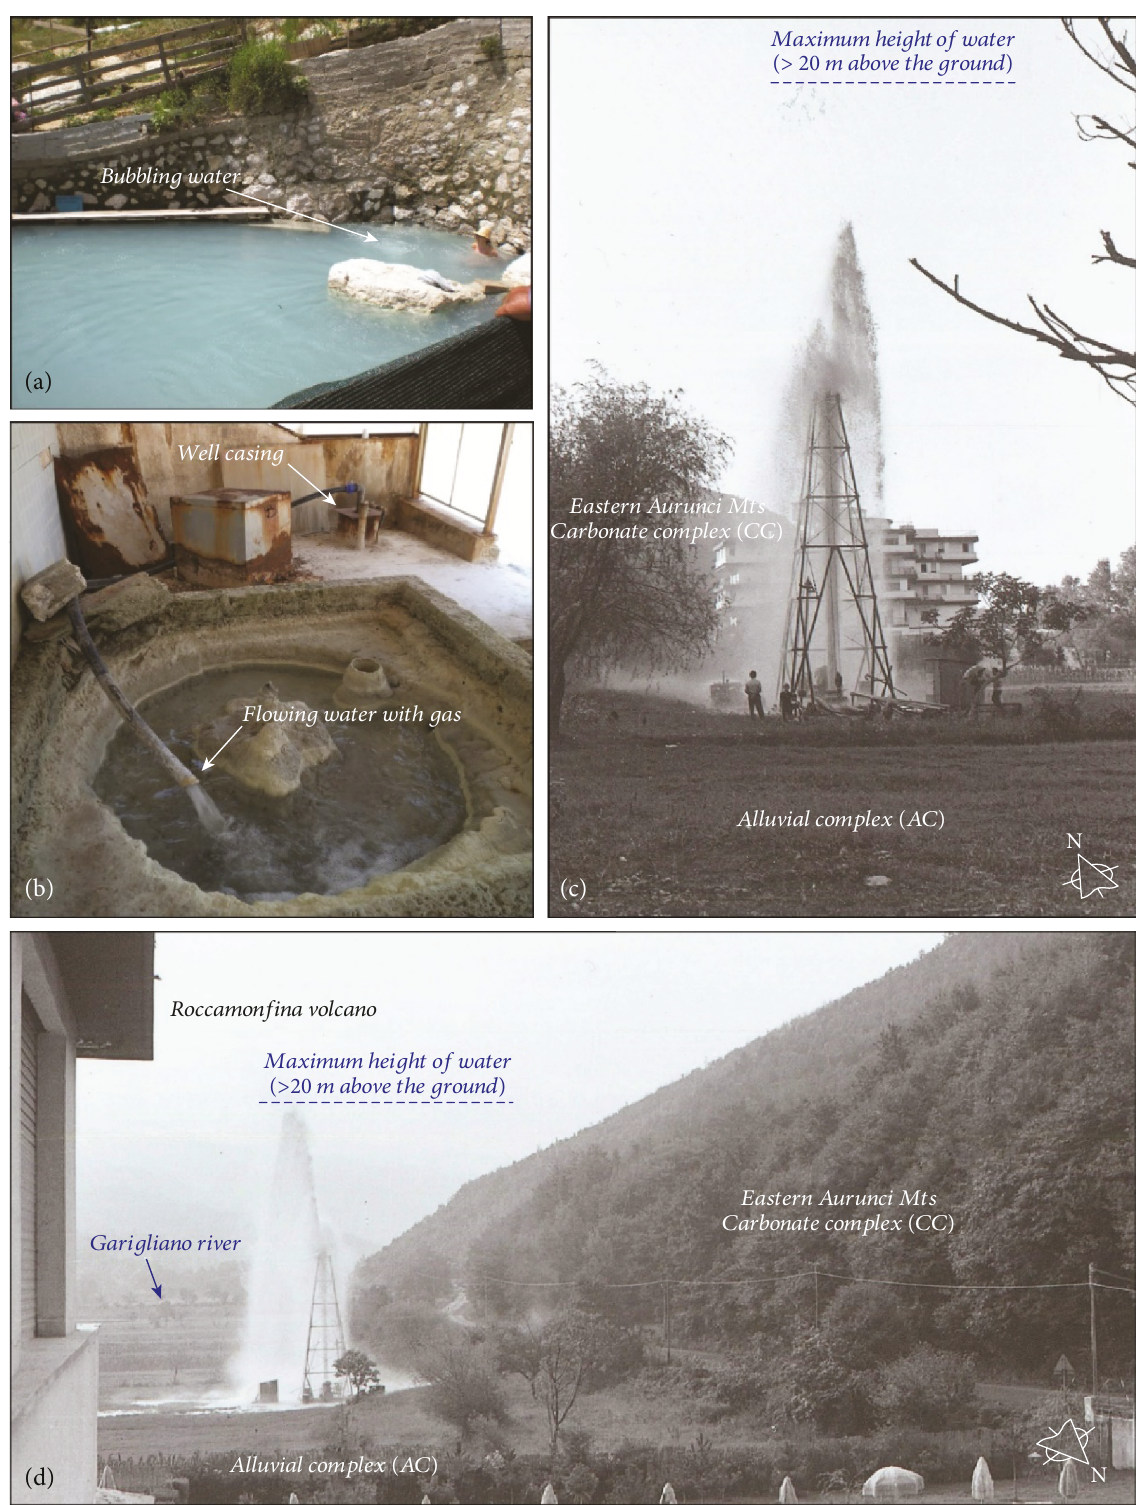
Figure 3: Examples of hydrothermal springs and water wells. (a) S9 spring, with a temperature up to 50 ° C. (b) W15 water well, whose apparent artesian behaviour is related to the degassing phenomenon. (c and d) Drilling of the W9 water well (1977). Images courtesy of Dr Geol. Francesco Nolasco. The images show the moment when the drilling reaches the deep hydrothermal water inside the carbonate complex (CC). The CO degassing rises the water column up to 20m above the 2